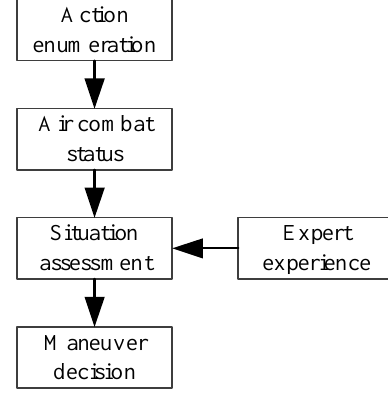
Figure 4. Strategy design of enemy aircraft.